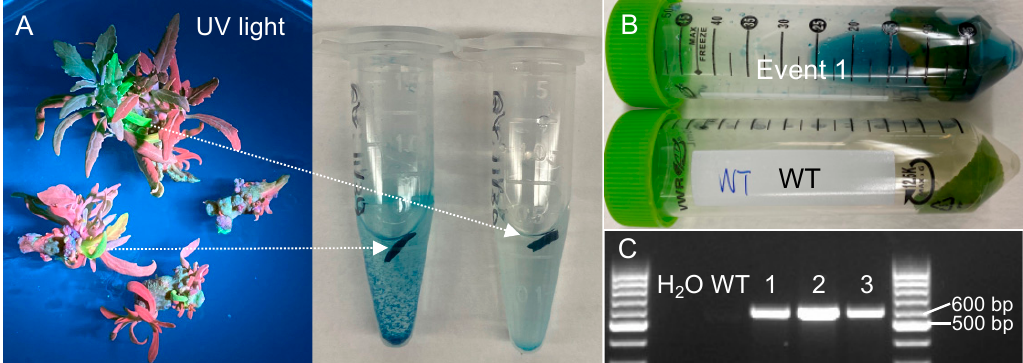
Figure 2. Verification of transgenic events selected based on eYGFPuv expression. ( A ) GUS staining of leaf samples collected from shoot elongation stage. ( B ) GUS staining of leaf samples collected from nine-week-old plant in soil. ( C ) PCR genotyping of transgenic events with green fluorescence.